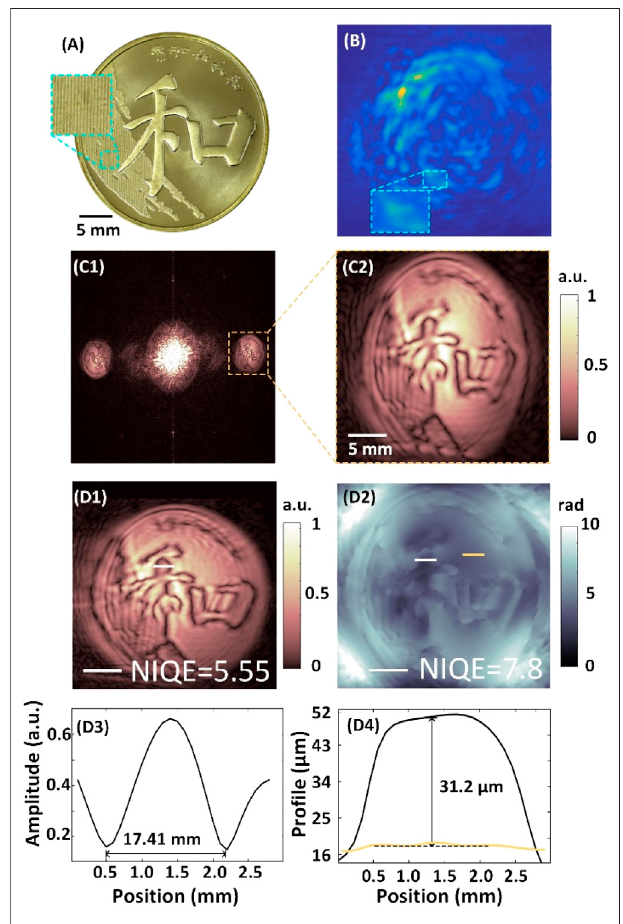
FIGURE 5 | Results of the commemorative coin. (A) Photo; (B) hologram; (C1) reconstructed amplitude image; (C2) enlarged real image in (C1) . (D1) and (D2) are the reconstructed amplitude and phase images after correction, respectively; (D3) and (D4) are the amplitude and thickness pro fi les of the cutting lines at the insets of (D1) and (D2)